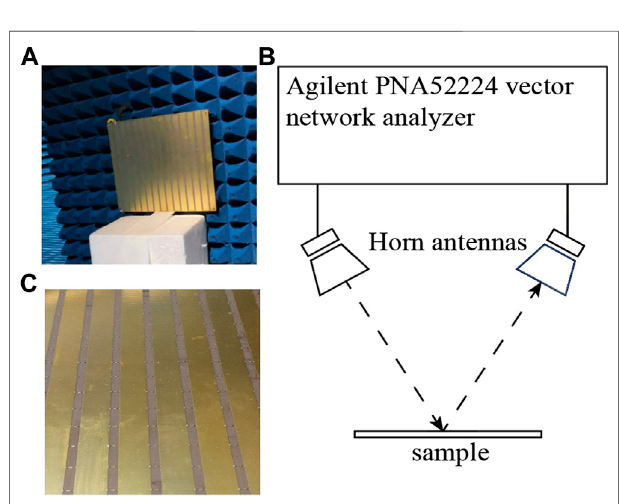
FIGURE 4 | (A) The photo of experimental setup of the re fl ection measurement, (B) schematic experimental setup, and (C) the close-up photo of the sample.